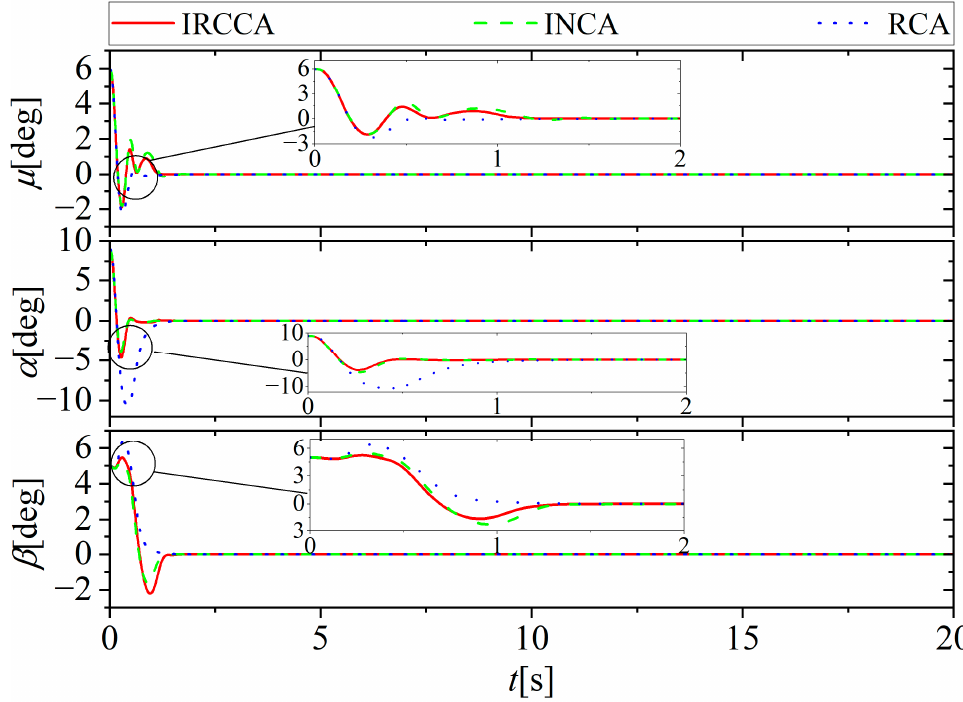
Figure 13. Time response of the attitude angle with a loss of effectiveness fault.